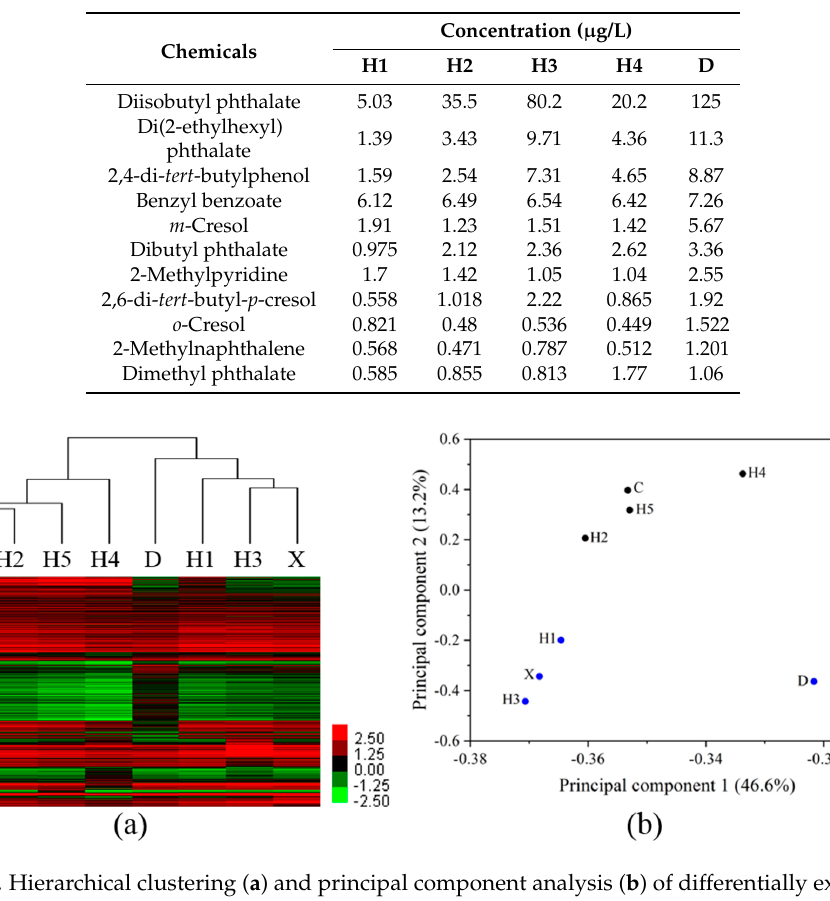
Figure 4. Hierarchical clustering ( a ) and principal component analysis ( b ) of differentially expressed genes in the liver of zebrafish exposed to river water of each site. Upregulated genes are marked in red and downregulated genes in green. Scale shows fold differences in expression versus controls ( a ).